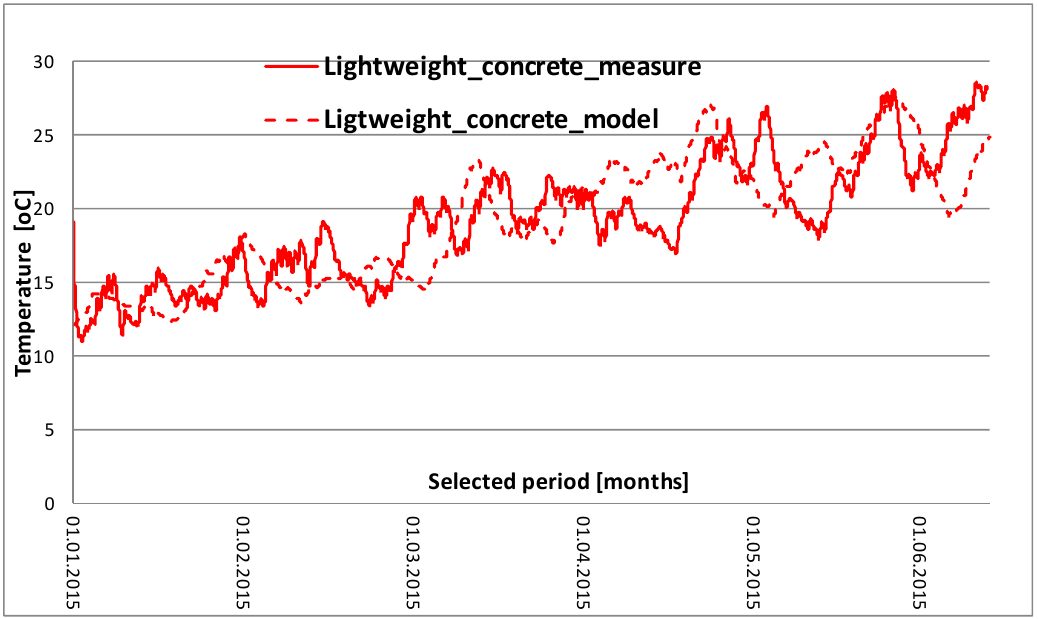
Figure 8. Temperature profile for the selected measurement places of the envelope. Collected results of the measurements and numerical modeling (description in the